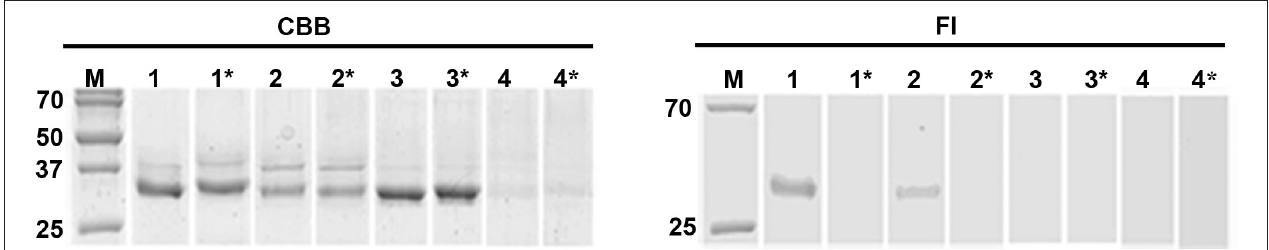
FIGURE 4 | Active site labeling of the pepTrCB1 forms by the cysteine peptidase-specific probe DCG-04. The pepTrCB1 forms were treated with the probe BODIPY green-DCG-04, resolved by SDS-PAGE, and stained with Coomassie Brilliant Blue (CBB) or visualized with a fluorescence imager (Fl). (1) TrCB1.1, (2) TrCB1.4, (3) TrCB1.6wt, (4) TrCB1.6G/C. Samples marked by asterisk were pre-incubated with E-64 inhibitor prior to labeling. M, markers of molecular size (kDa). Note the autodegradation of TrCB1.6G/C (lanes 4 and 4*) during incubation with the probe/inhibitor, resulting in weak protein bands.